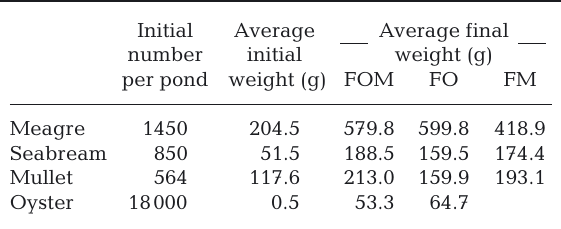
Table 1. Number and weight of fish and oysters introduced into the 3 types of experimental pond. FOM: fish,